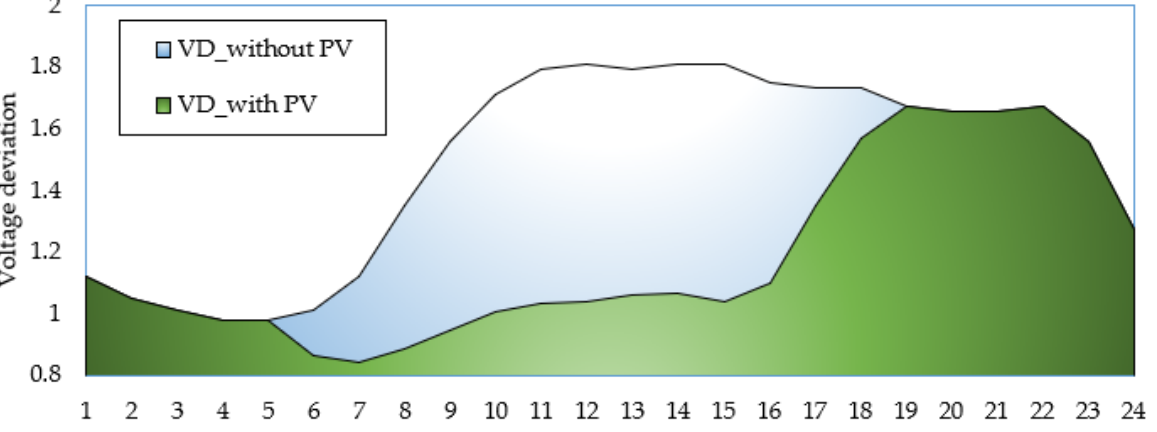
Figure 10. Hourly voltage deviations for the second scenario compared to the first scenario for the IEEE 33-distribution system.